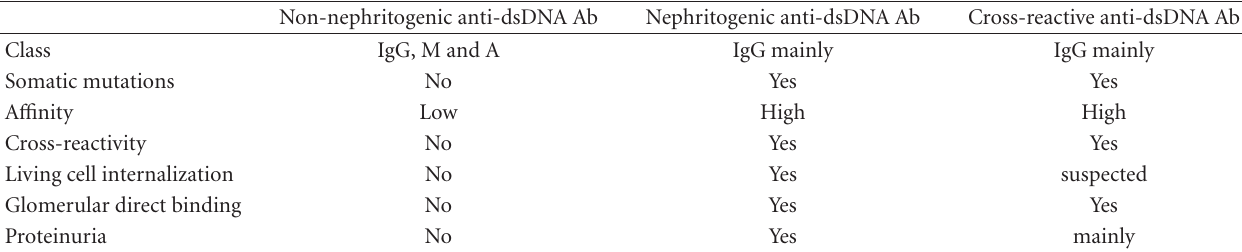
Table 3: Nephritogenic and cross-reactive anti-dsDNA Ab properties